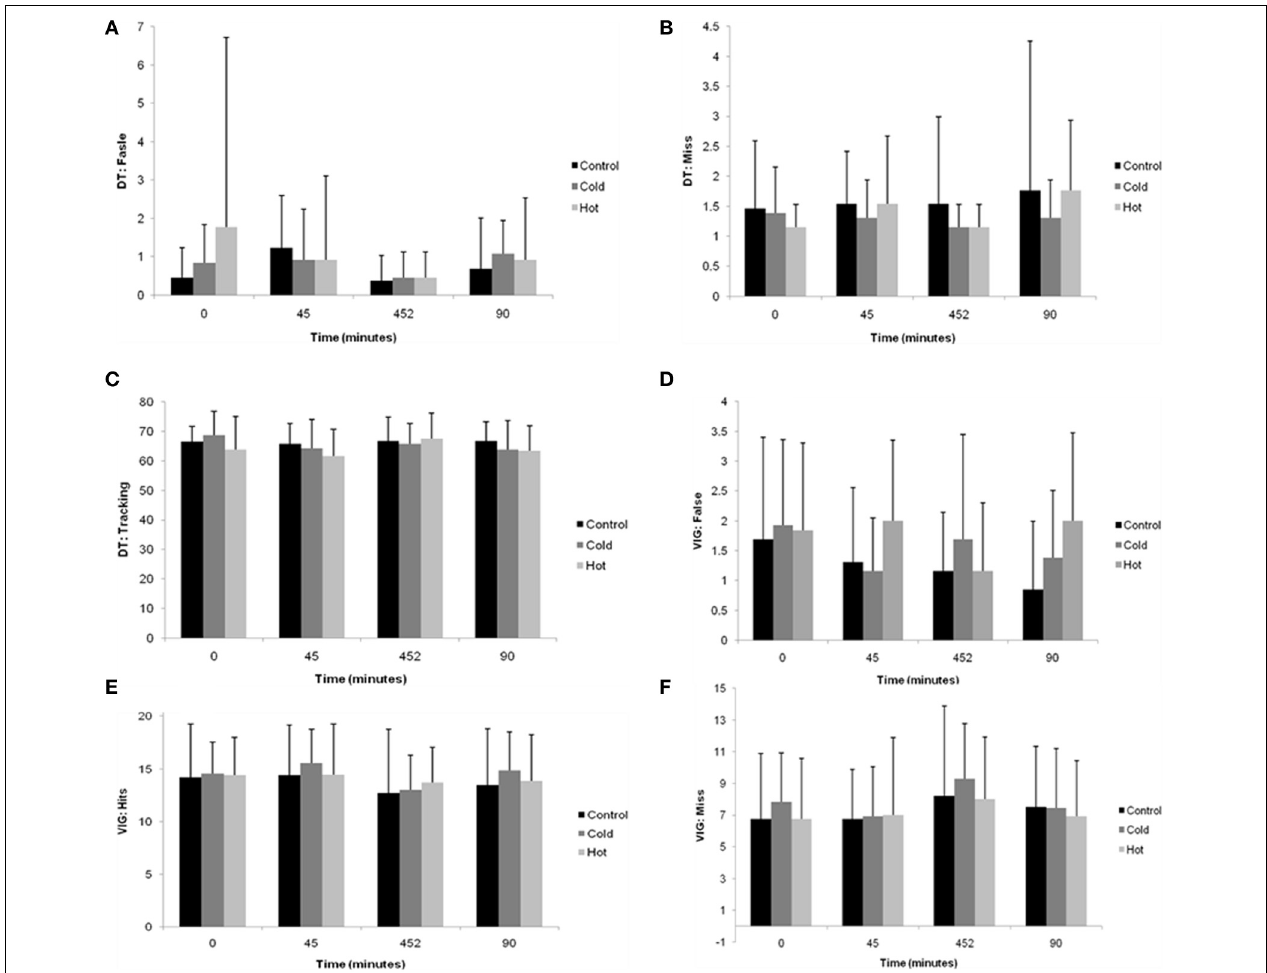
FIGURE 3 | Mean (SD) dual task scores during the 90min intermittent sprint exercise protocol in CONT, HOT, and COLD conditions (A) FALSE, (B) MISS, and (C) TRACKING. Mean (SD)